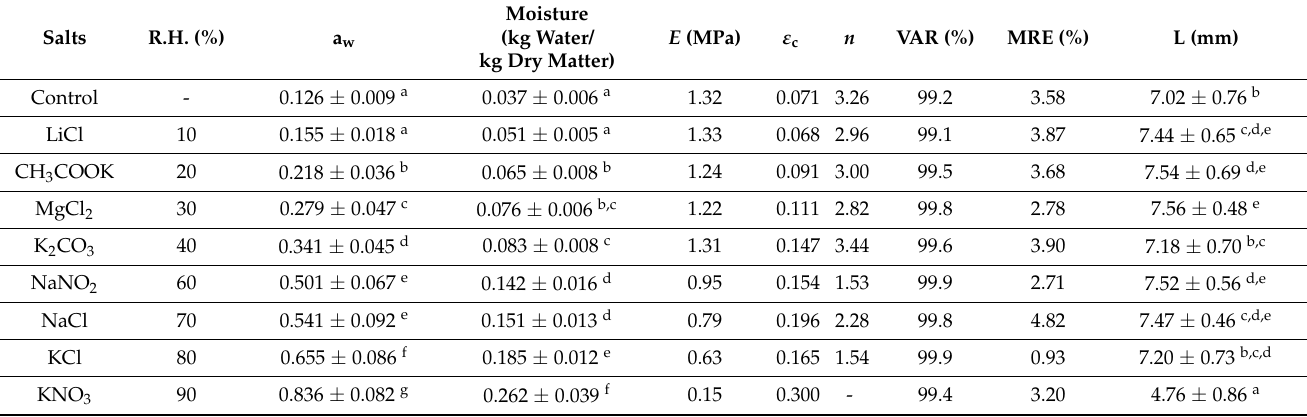
Table 1. Results for the adsorption experiments in puffed corn cakes and textural model